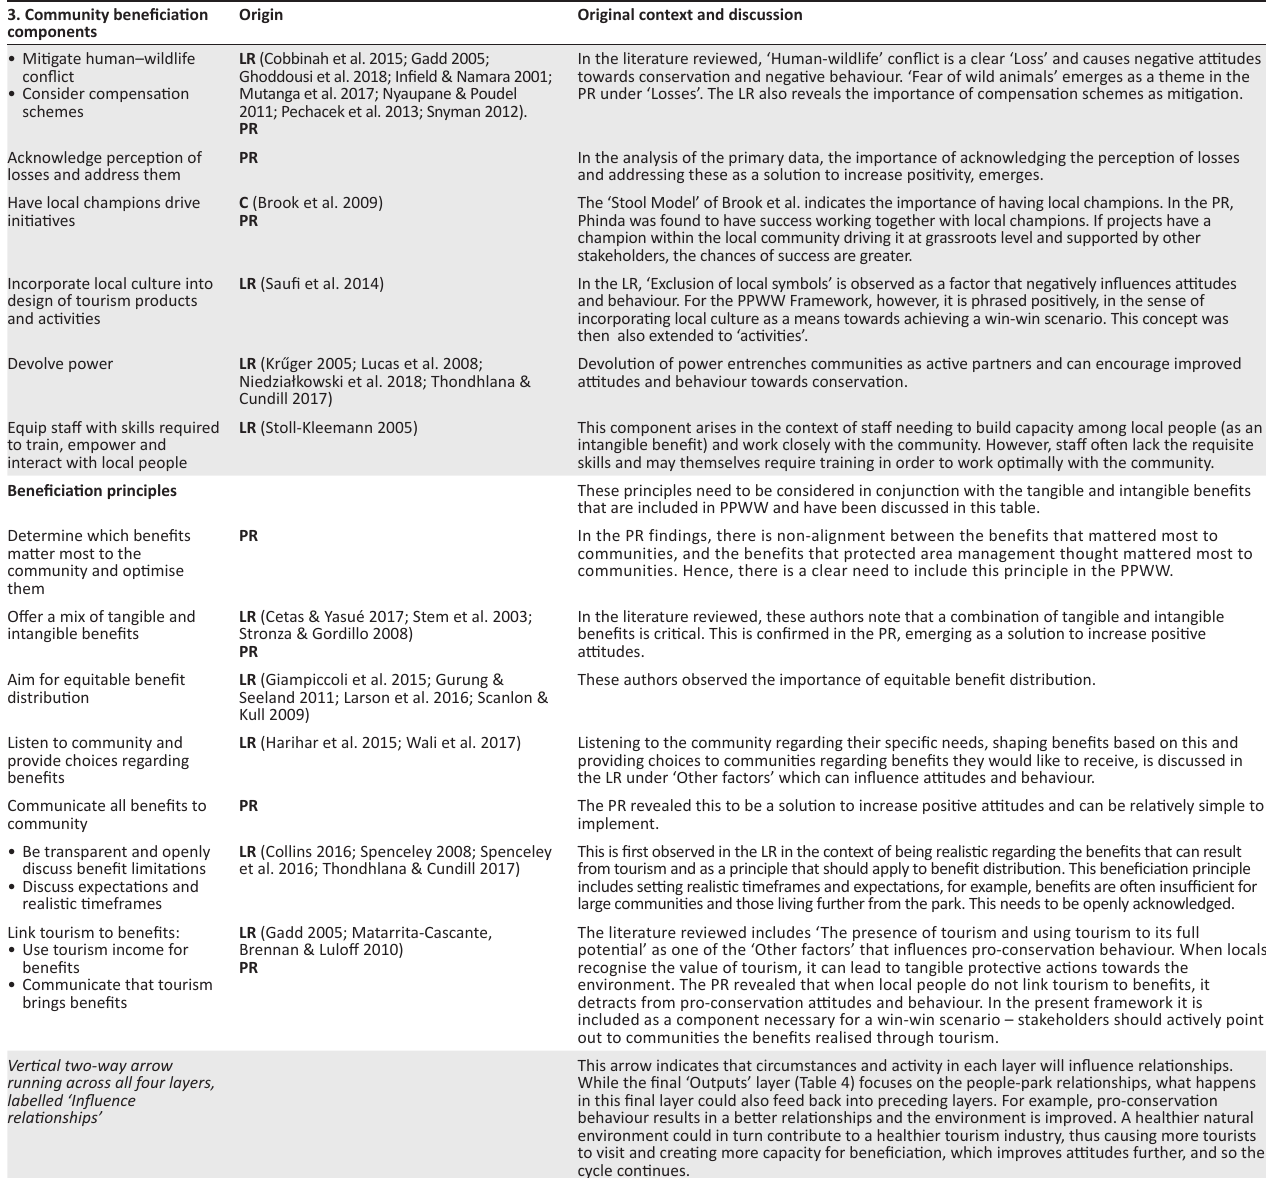
TABLE 3 (Continues…): Layer 3 and components used to build the People Parks Win-Win